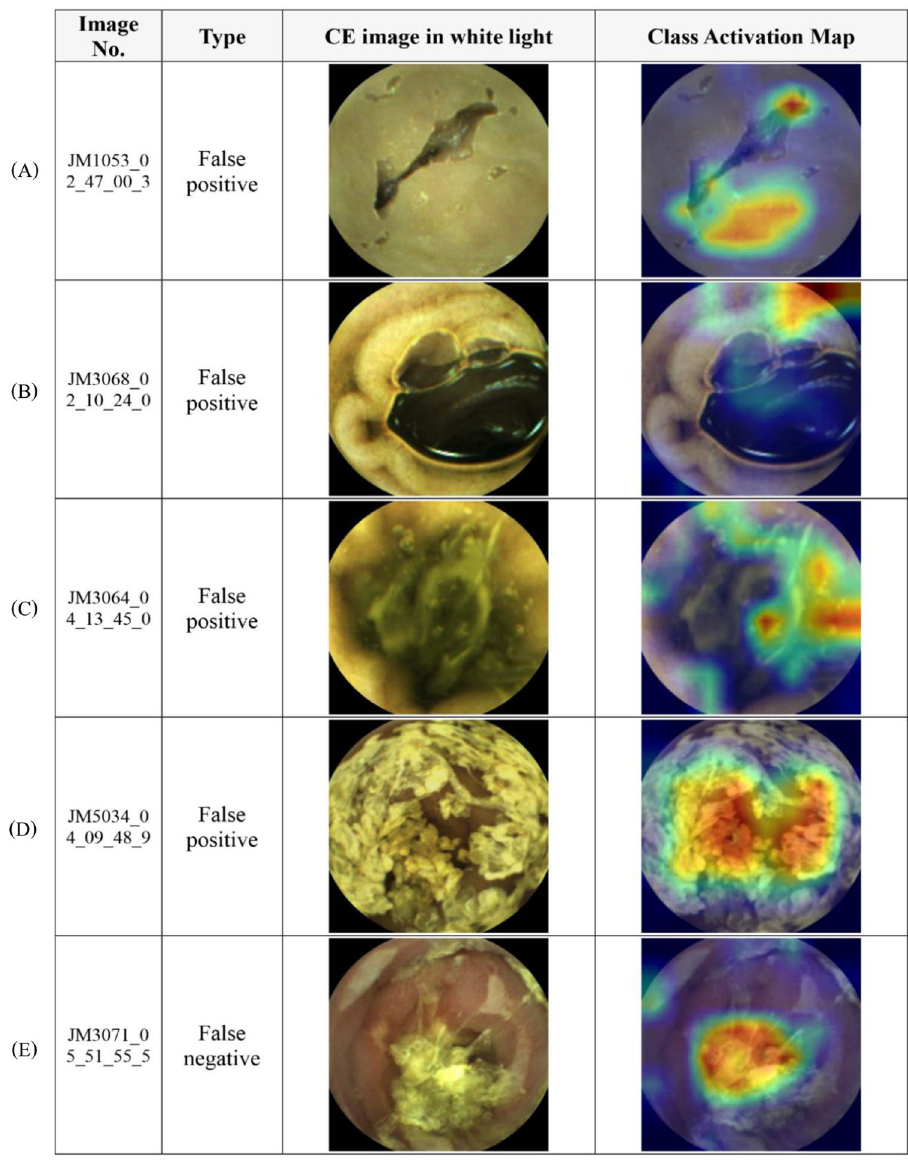
Figure 6. Examples of Several Class Activation Maps of Misclassified Images. ( A ) Is a case of incorrect detection of induration caused by capsule and small bowel mucosa adhesion. ( B ) Is misclassified as ’significant’ for bends around a large bubble. ( C ) Is a case that was successful in discriminating bile and debris but misclassified as ’significant’ for a peripheral dimmed lesion with a flow of bile. ( D ) Is misclassified semi-solid debris as ’significant’ lesion. ( E ) Is a case showing inappropriate higher activation in debris rather than focusing on inflammation and hyperemia of the mucosa. (Capsule endoscopy image taken by Mirocam MC1600, processed by MiroView 4.0—http:// www. intro medic. com/ eng/ main).